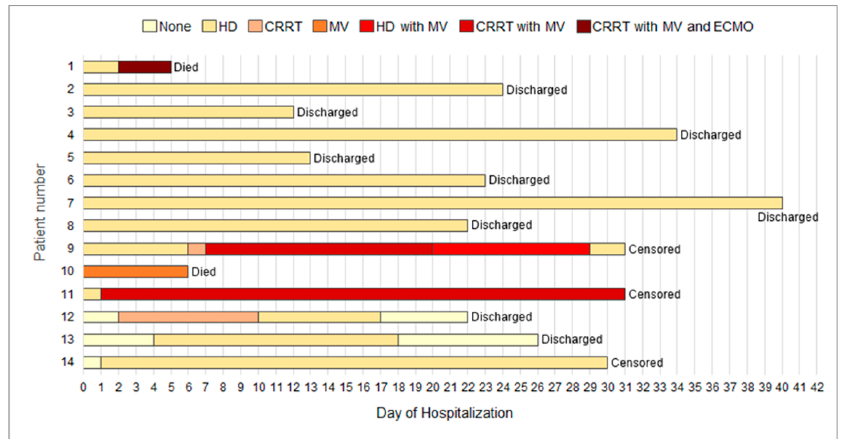
Figure 3. Clinical courses and outcomes for individual patients with end-stage renal disease and COVID-19. As of 14 April, 2020, a total of 2 (14.3%) patients had died, 9 (64.3%) had been discharged, and 3 (21.4%) remained under treatment. Abbreviations: COVID-19, coronavirus disease 2019; HD, hemodialysis; CRRT, continuous renal replacement therapy; MV, mechanical ventilation;